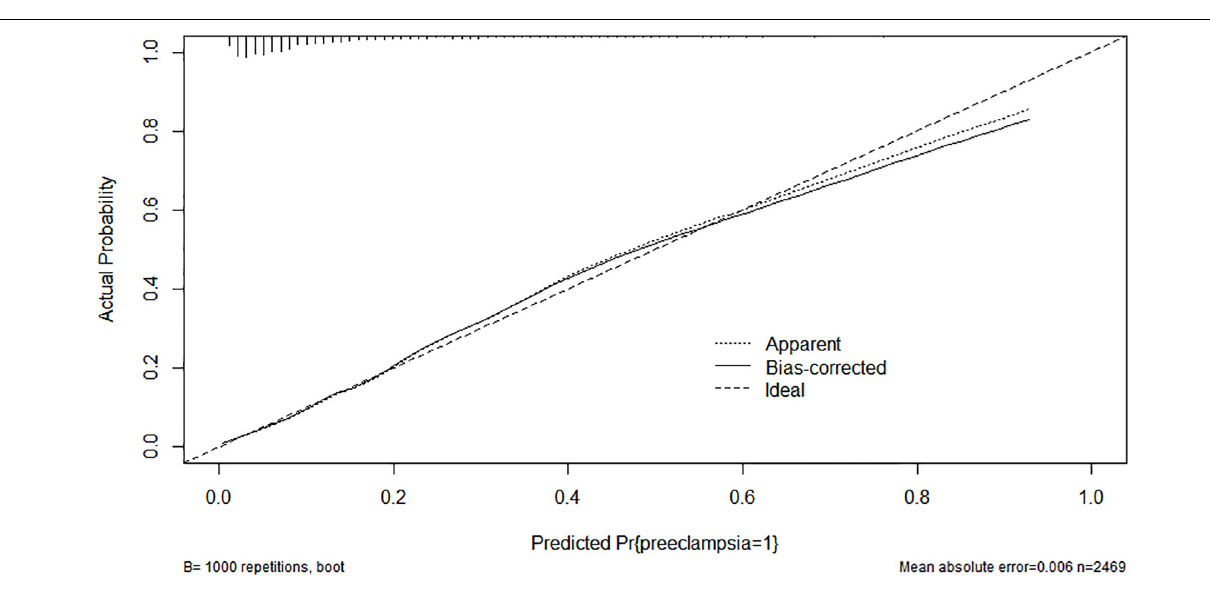
FIGURE 5 | Calibration curves for predicting the risk of preeclampsia in twin pregnancies—nomogram construction (bootstrap = 1 000